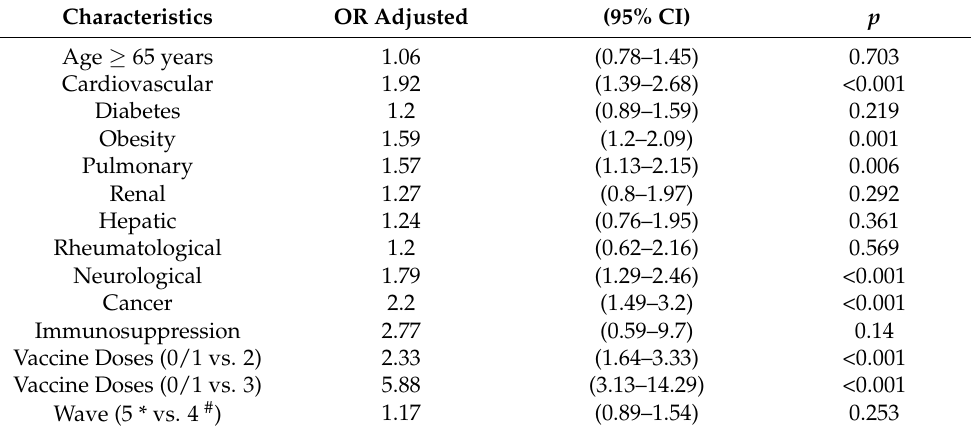
Table 4. Results of the multivariate logistic regression model predicting intensive care need.